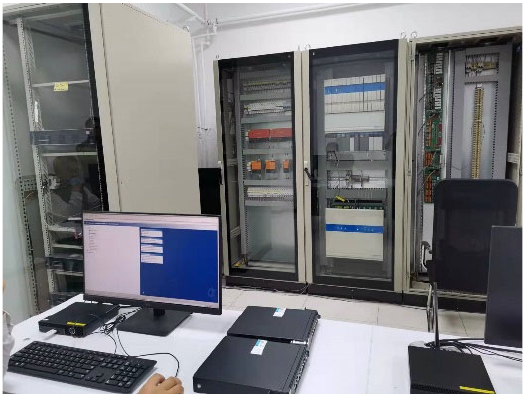
Figure 5. The central control platform.